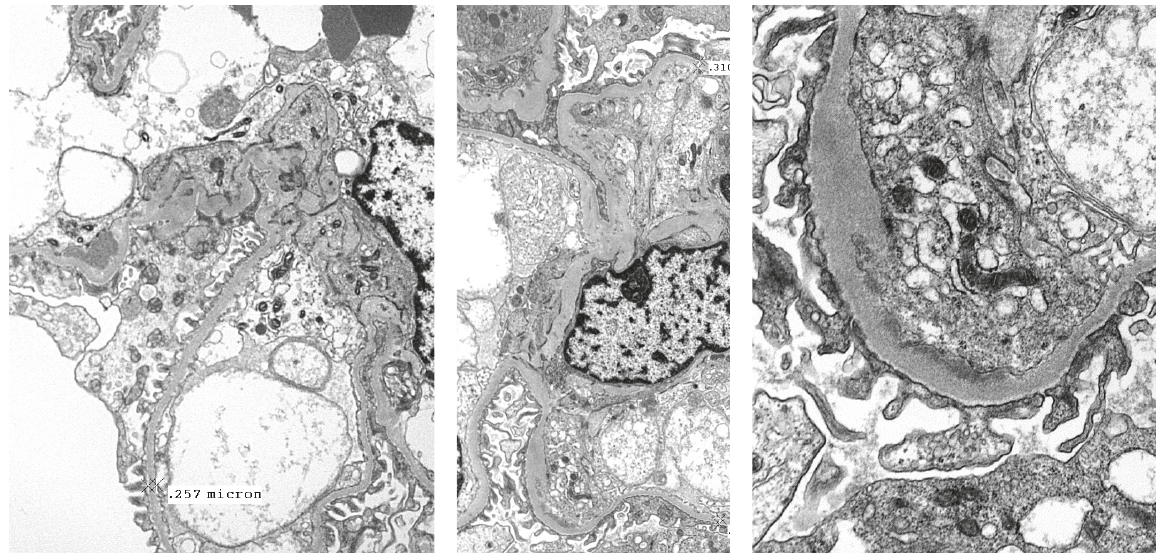
Figure 3: Electron microscopy images showing subendothelial electron-dense